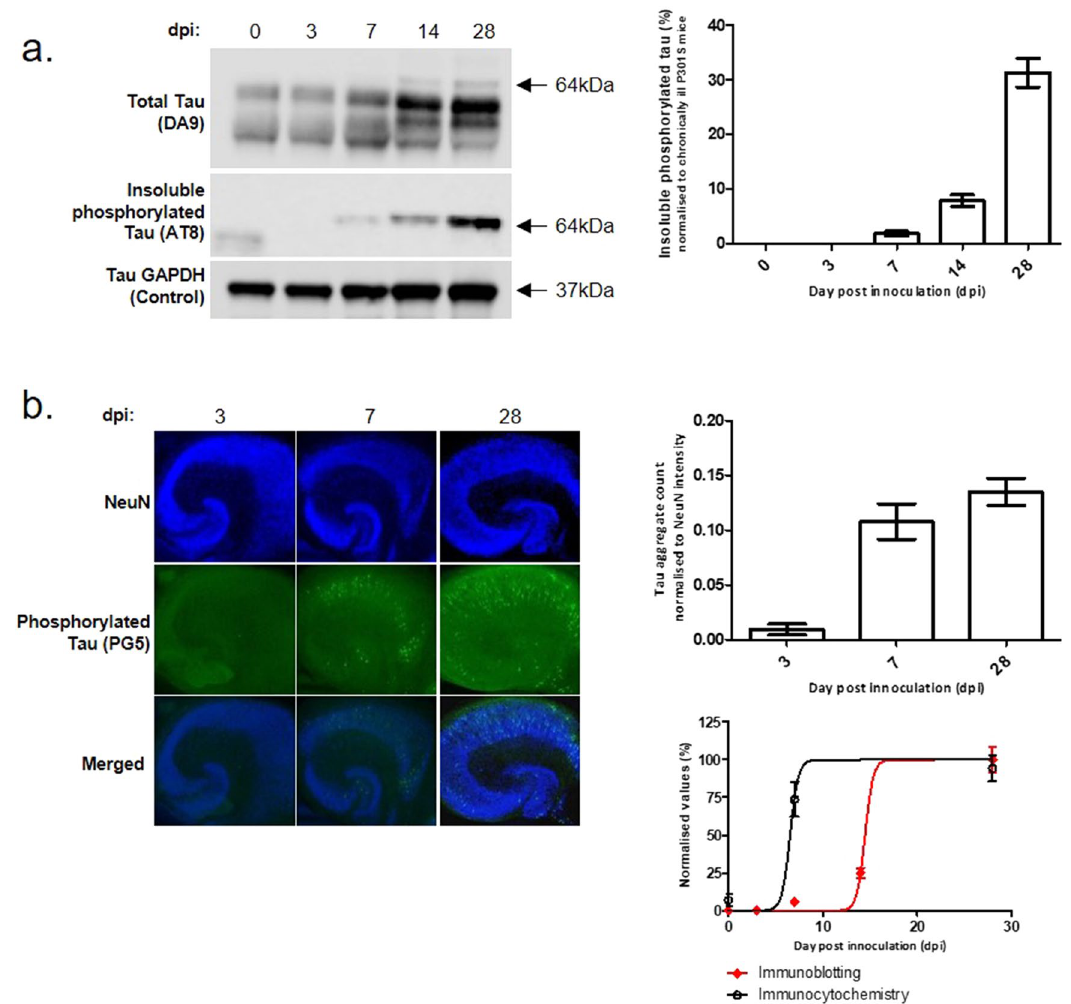
Figure 4. A slow progressive increase in insoluble phosphorylated tau is observed over time in culture. OHCs from P7 P301S and WT mice were seeded immediately after preparation with brain homogenate from terminally ill P301S mice or aged matched WT mice. ( a ) Slices were cultured for 0, 3, 7 or 28 days, lysed, fractionated and analyzed via immunoblotting for insoluble phosphorylated tau or ( b ) fixed and stained for analysis of PG5 + tau. The level of insoluble tau increased over time up to 28 days. Western blot image cropped for focus. For full original image see Supp Fig.